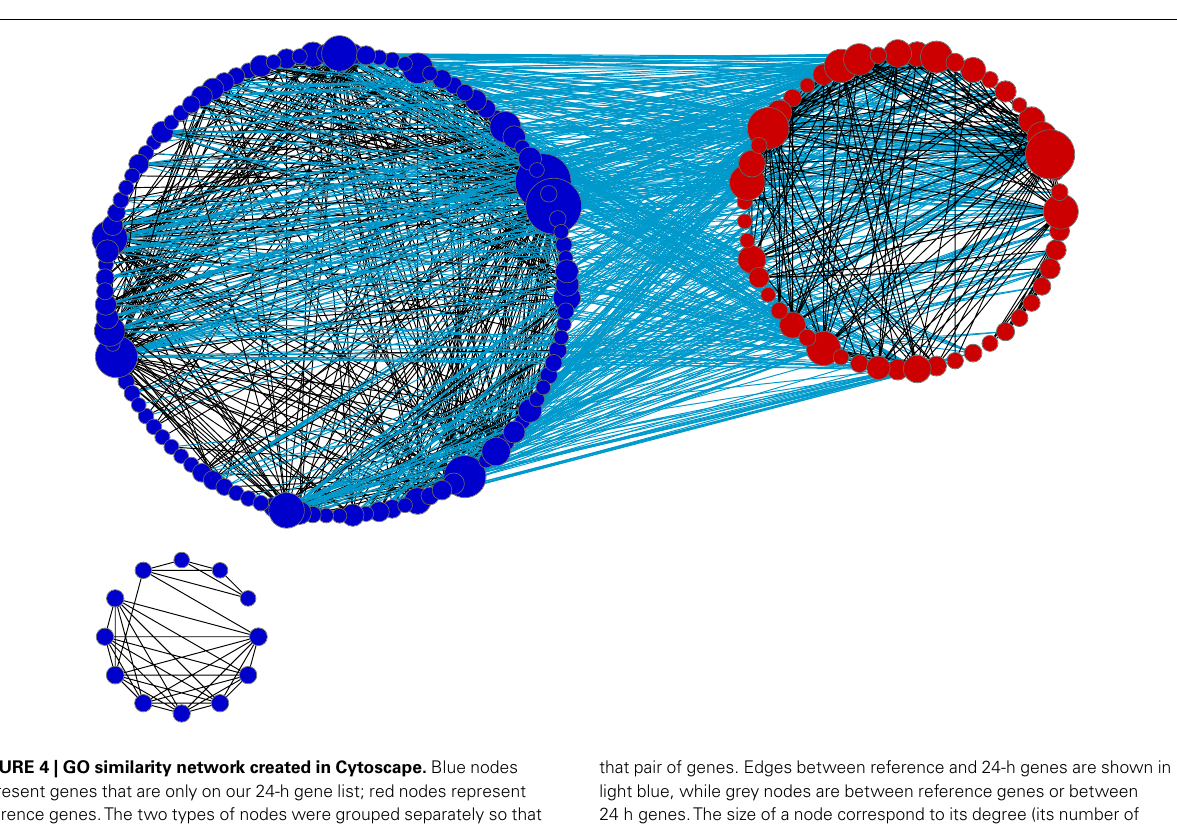
that pair of genes. Edges between reference and 24-h genes are shown in light blue, while grey nodes are between reference genes or between 24 h genes. The size of a node correspond to its degree (its number of edges). Genes which lack GO similarity of at least 60 to another gene are not